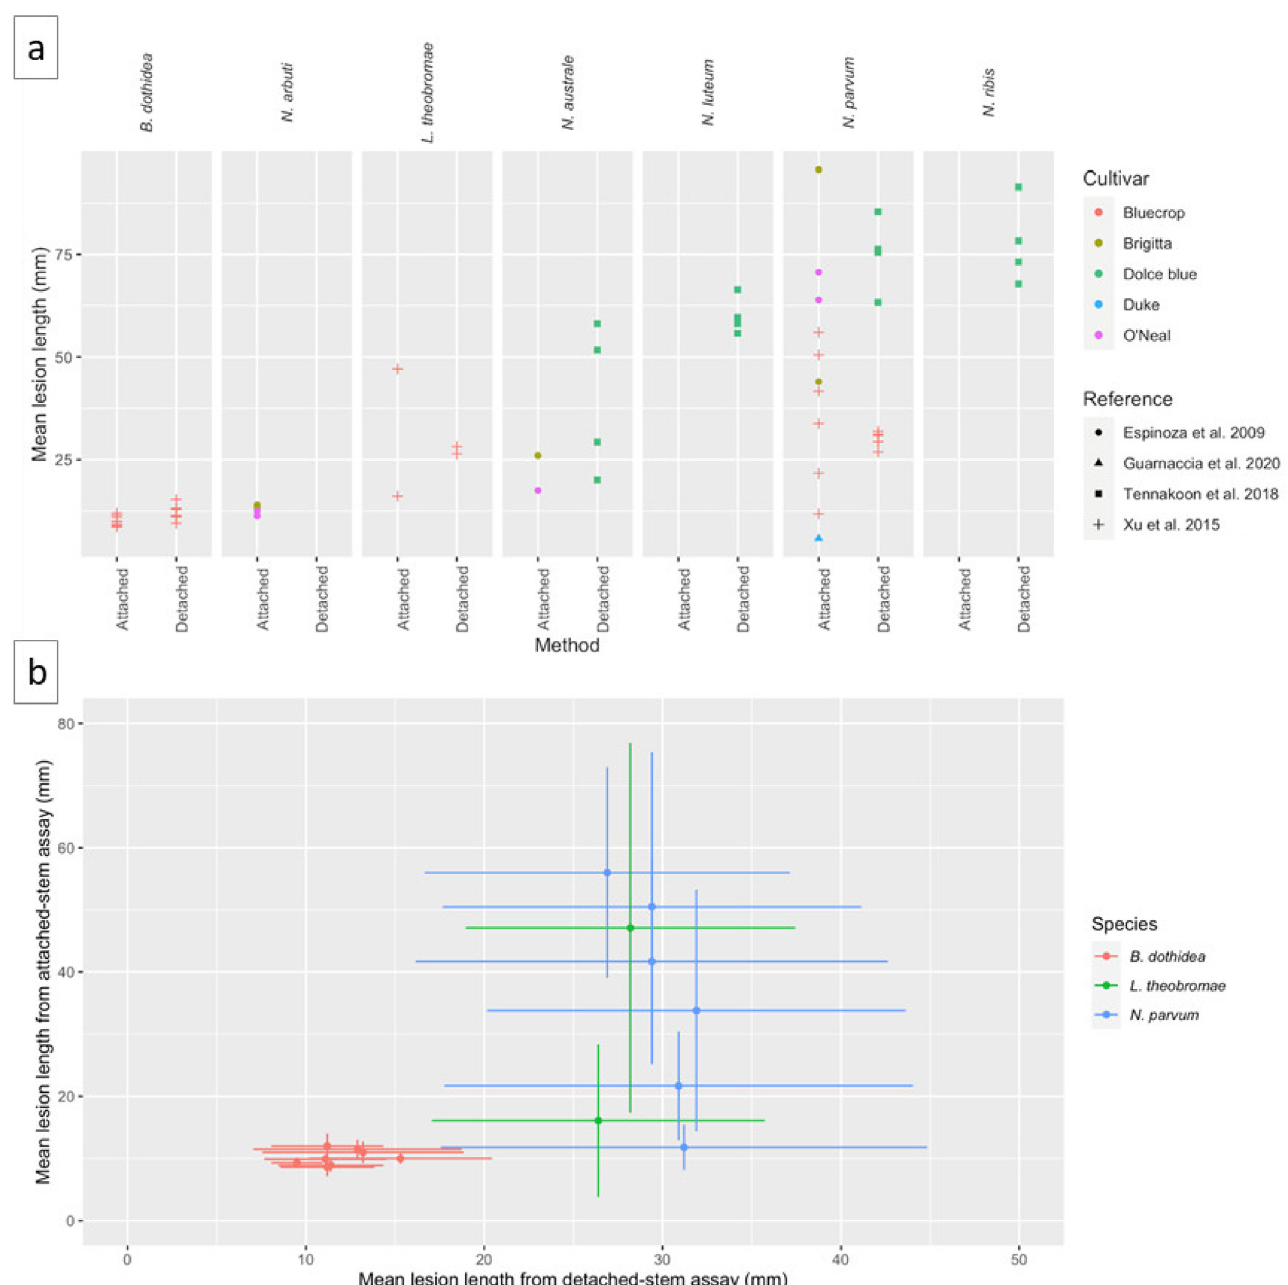
Figure 3. Comparisons of mean lesion lengths of pathogenicity and virulence tests. ( a ) Pathogenicity and virulence test results with different methods, isolates, species, and blueberry cultivars from five studies. Attached: attached-stem assay, Detached: detached stem assay. Data for ‘Bluecrop’ was obtained from 1 Xu et al. [6], ‘Brigitta’ and ‘O’Neal’ from 2 Espinoza et al. (2009) [28], ‘Dolce blue’ from 3 Tennakoon et al. [18], ‘Duke’ from 4 Guarnaccia et al. [30]. ( b ) Mean lesion lengths on infected ‘Bluecrop’ using attached- and detached-stem assays. Horizontal error bars represent standard deviation for detached-stem assay, vertical error bars stand for standard deviation for attached-stem assay. Multiple isolates of B. dothidea , L. theobromae , and N. parvum were used to inoculate ‘Bluecrop’. Data were obtained from Xu et al.